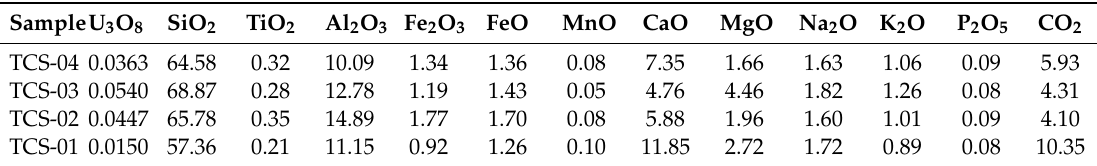
Table 5. Geochemical composition of uranium ore samples (wt.%).